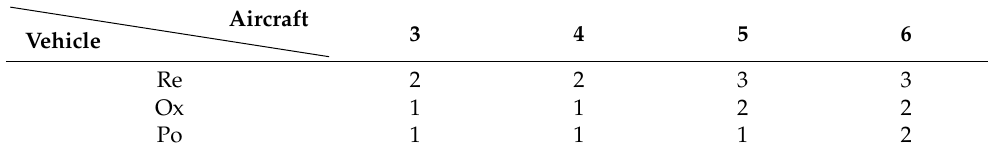
Table 7. Number of support vehicles for a certain type of aircraft. Vehicle